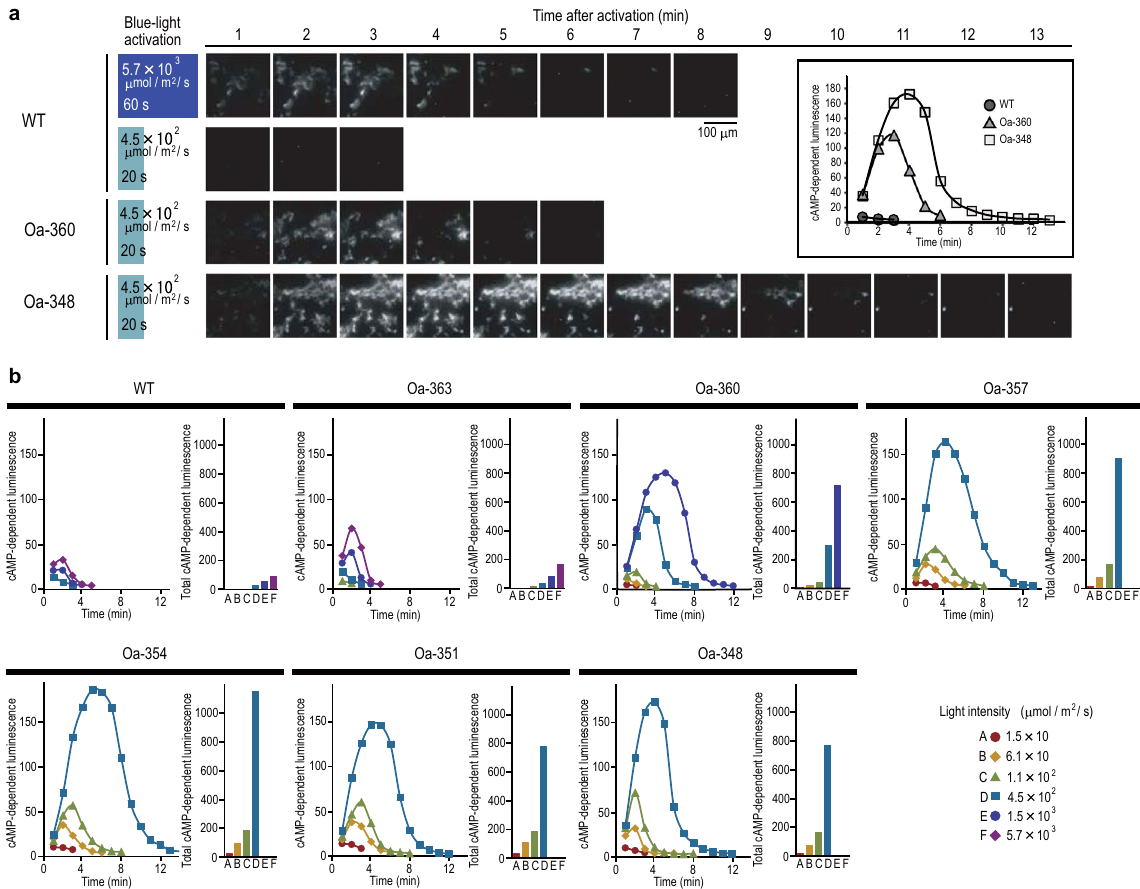
Figure 2. C-terminal deletion mutants showed high photoactivity. HEK cells expressing WT, Oa-360, and Oa-348 were exposed to blue light, and the resulting cAMP-dependent luminescence was detected. ( a ) Representative sequential luminescence images after illumination. The inset shows quantitative plots of luminescence intensities after exposure to blue light at 4.5 × 10 2 µ mol m − 2 s − 1 for 20 s. Under the same irradiation condition (4.5 × 10 2 µ mol m − 2 s − 1 for 20 s), the luminescence of Oa-348 and Oa-360 was obviously high, while that of the WT was mostly undetectable. The luminescence of the WT was clearly detected by longer exposure to more intense blue light (5.7 × 10 3 µ mol m − 2 s − 1 , 60 s). ( b ) Time course of cAMP-dependent luminescence intensities (left) and integrated luminescence intensities (right) at indicated blue light intensities. C-terminal deletion mutants were activated by weaker blue light intensities, and they produced a larger amount of cAMP than the